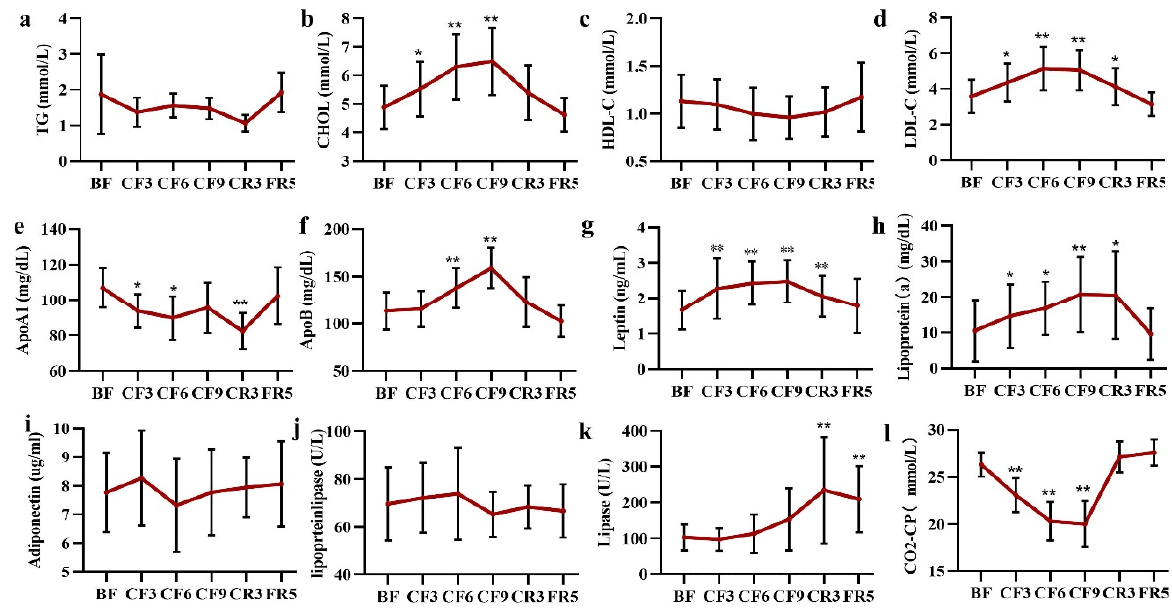
Figure 6. The changes of lipometabolic indices during 10-day CF and refeeding period. ( a – l ) represent the Y-axis coordinates. * p < 0.05, ** p < 0.01 vs. BF; n = 13. BF: before fasting, CF: complete fasting, CR: